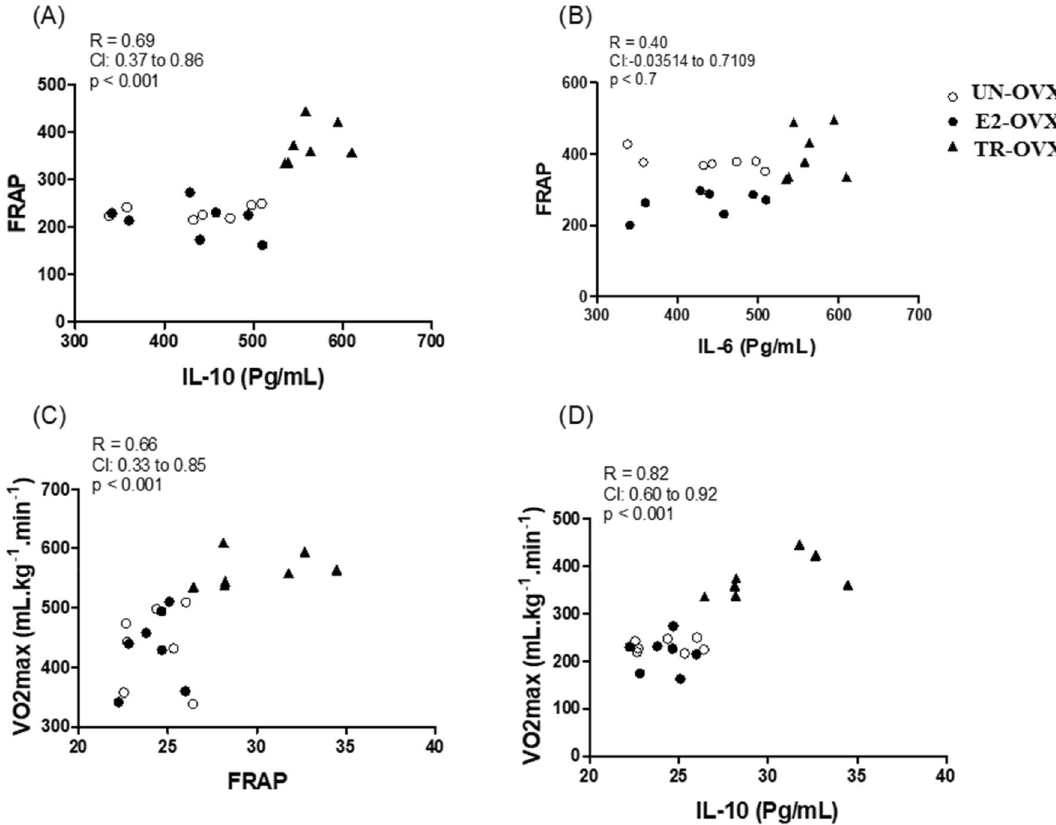
Figure 5. Correlations of the ferric reducing ability of plasma (FRAP) with interleukin 10 (IL-10) ( A ), interleukin 6 (IL-6) ( B ), and maximal oxygen consumption (VO 2max ) with FRAP ( C ) and IL-10 ( D ). The open circle (white) represents untrained ovariectomized rats (UN-OVX). A closed circle (black) represents ovariectomized rats treated with Estradiol replacement (E2-OVX). A closed triangle (black) represents trained ovariectomized rats